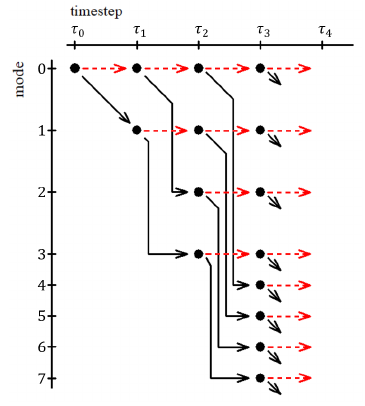
Figure 1. Propagation of Gaussian modes: Bullets symbolize propagating Gaussian modes. Red dashed arrows pointing to the right indicate mode propagation due to operator A, black arrows indicate the e ff ect of the scattering